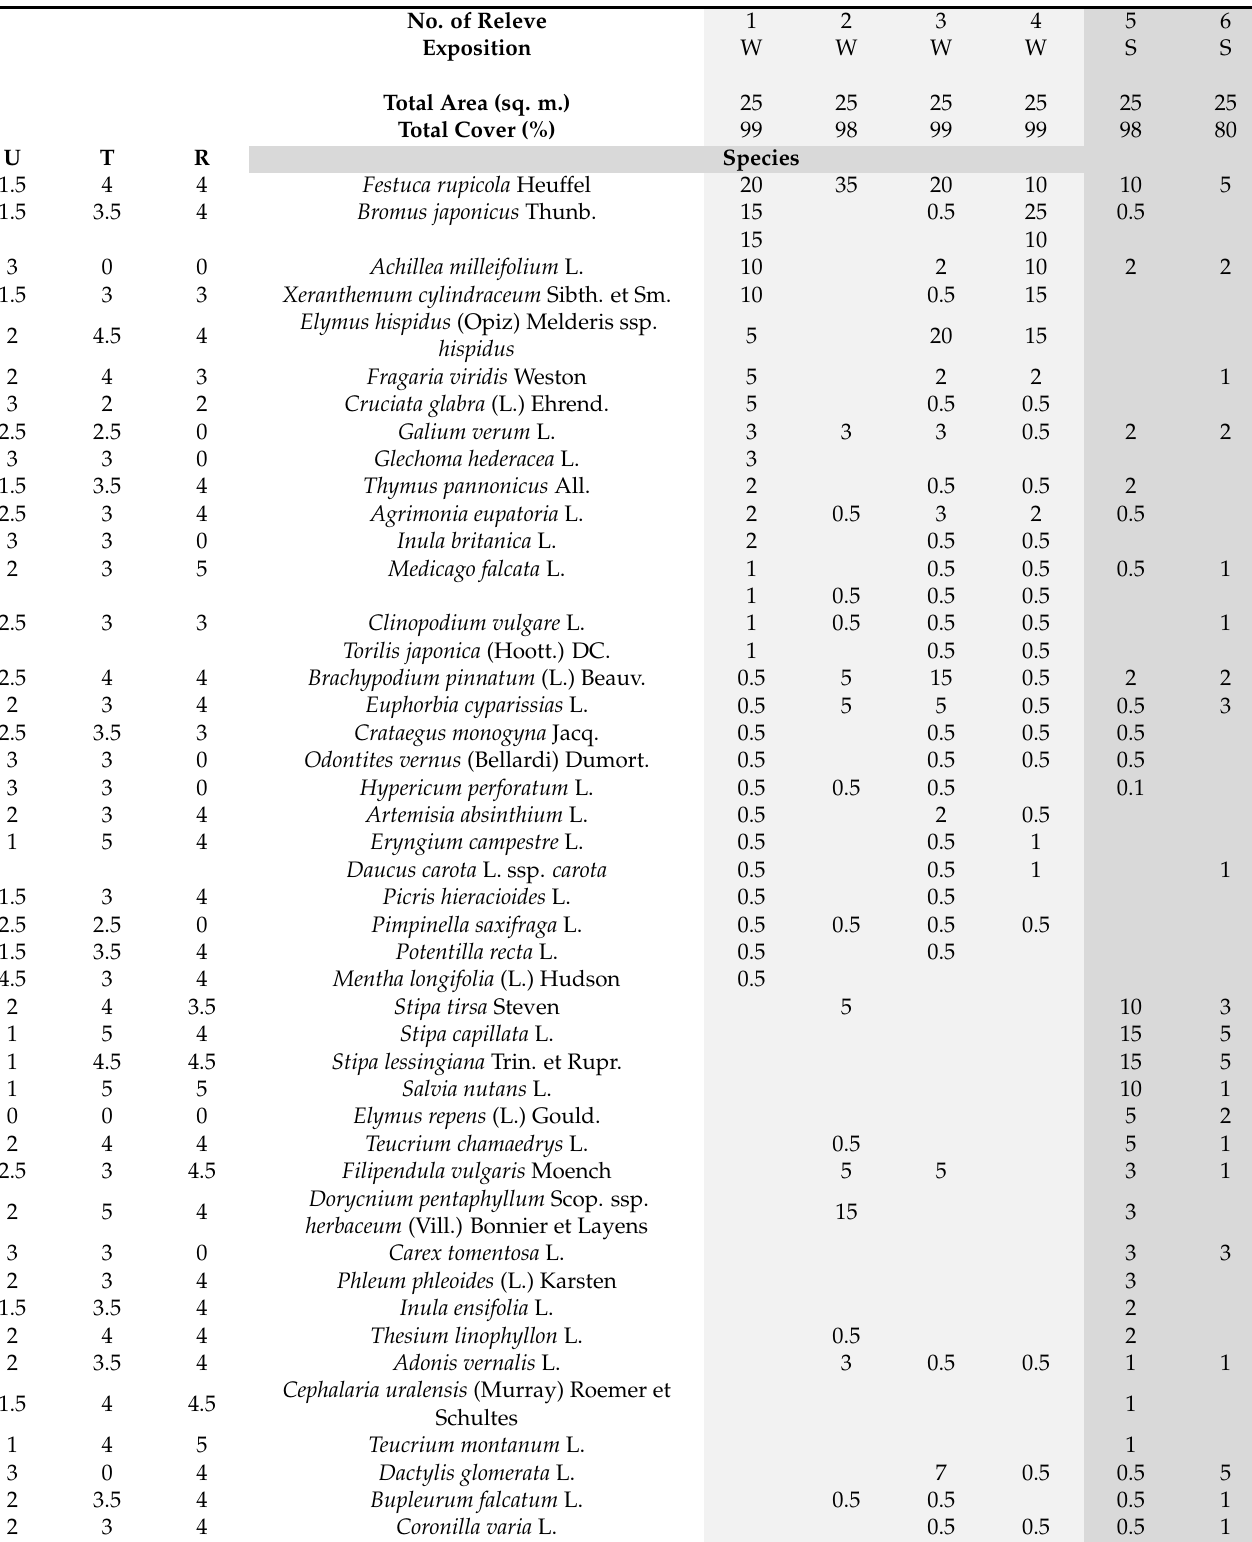
Table A2. Vegetation structure in ROSCI0295 Dealurile Clujului Est—Jucu de Sus (releves 1–4) and ROSCI0238 Suatu– Cojocna–Crairat–Cojocna (releve 5–6). Natura 2000 habitat: releve 1–4—6210 Semi-natural dry grasslands and scrubland facies on calcareous substrates (Festuco-Brometea); releves 5–6—6240* Sub-pannonan steppe